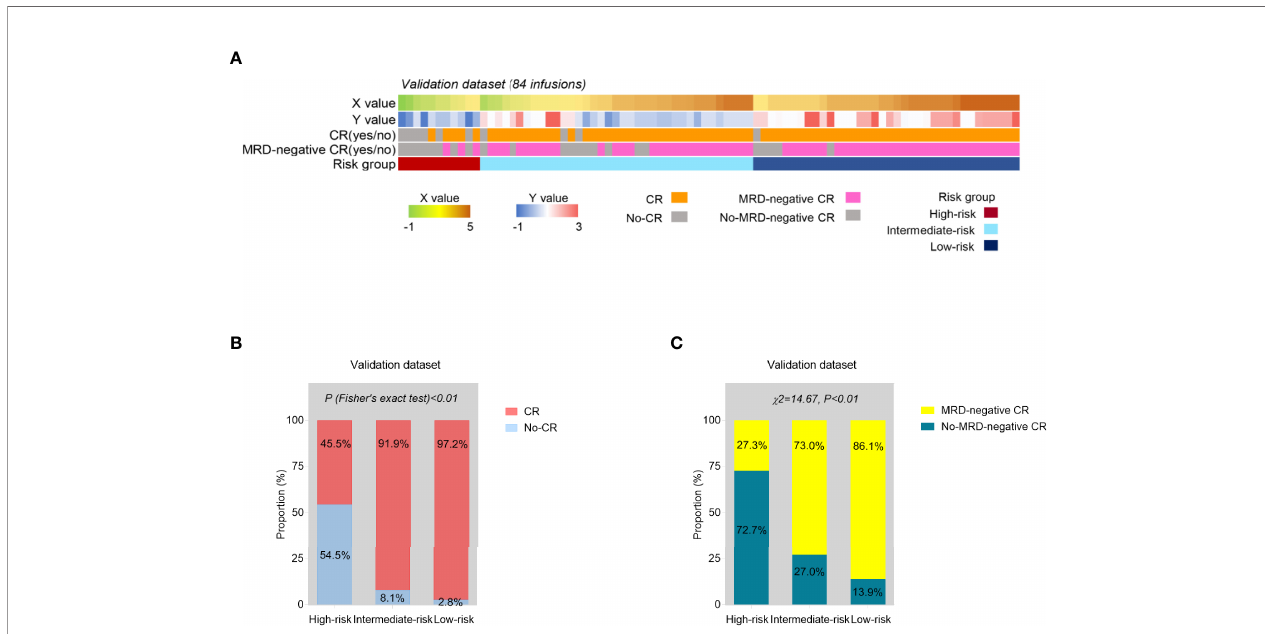
FIGURE 5 | Internal validation of the risk model. (A) The predicted probability score of CR (X) and MRD-negative CR (Y) and risk group based on the constructed models, and the actual treatment response of each time of CAR-T cell infusion in the validation series (N = 84). (B, C) The proportions of CR (B) and MRD-negative CR (C) infusions were compared among three risk groups from the validation set. p values were calculated via Fisher ’ s exact test (B) and chi-square ( c 2 ) test (C)